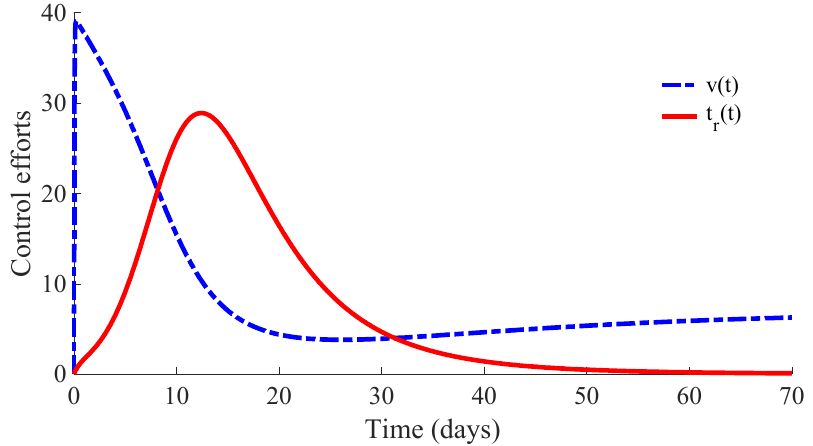
Figure 6. Time evolution of the control efforts: vaccination and treatment.